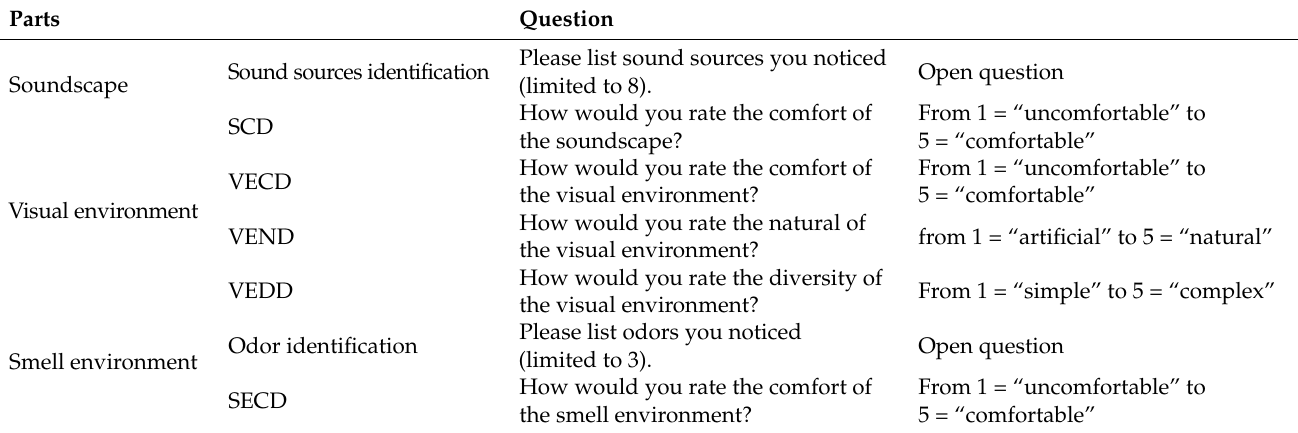
Table A1. The details of the questionnaire.